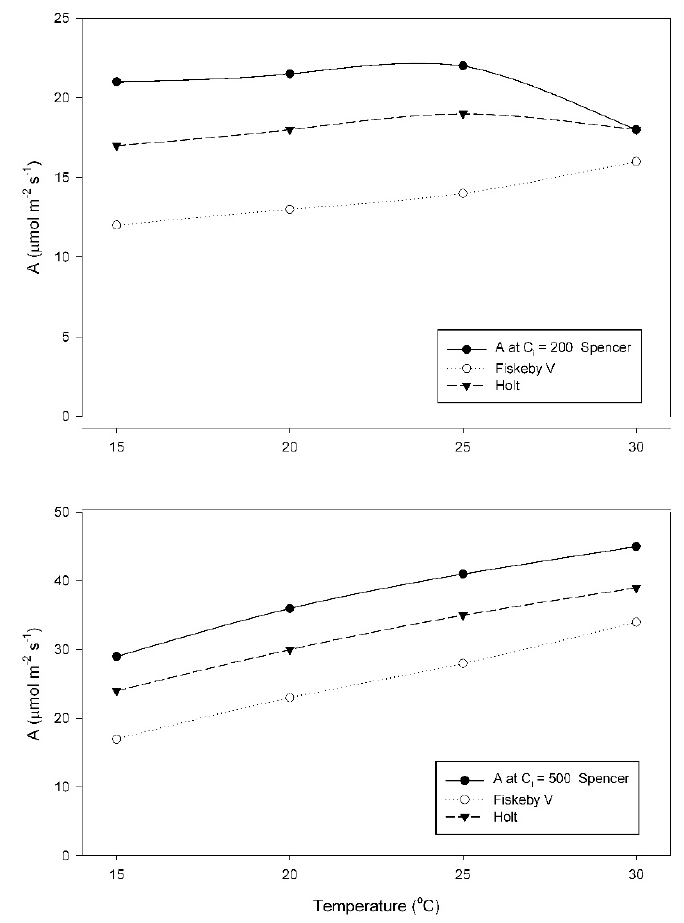
Figure 2. Values of A measured at either sub-stomatal CO 2 concentration (C i ) = 200 μ mol mol − 1 , or at C i = 500 μ mol mol –1 CO 2 for three soybean cultivars grown at 15 °C. Each point represents a mean for 3 or 4 leaves. Statistical comparisons are given in Tables A1 and